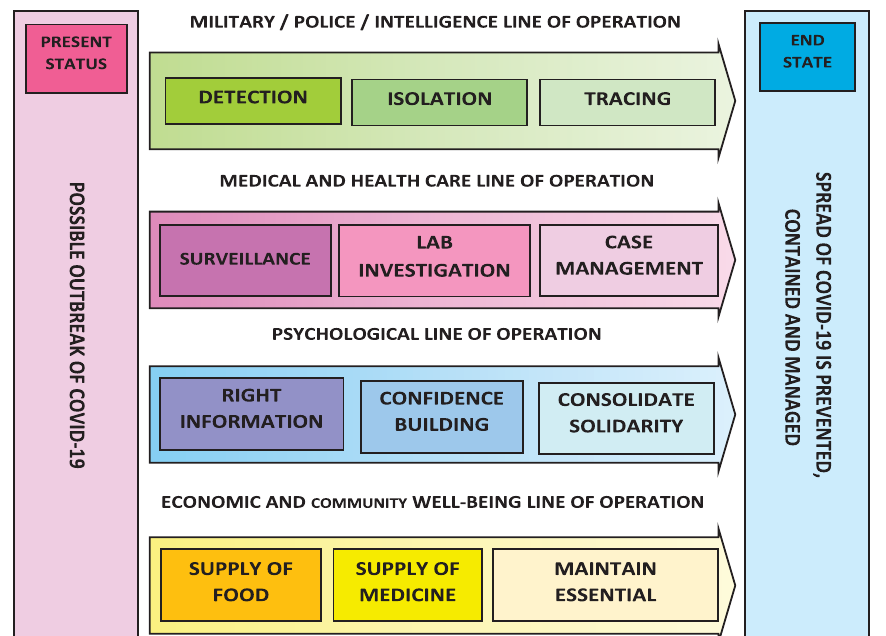
Figure 1: Conceptualization of the Whole-of-Government Approach in COVID-19